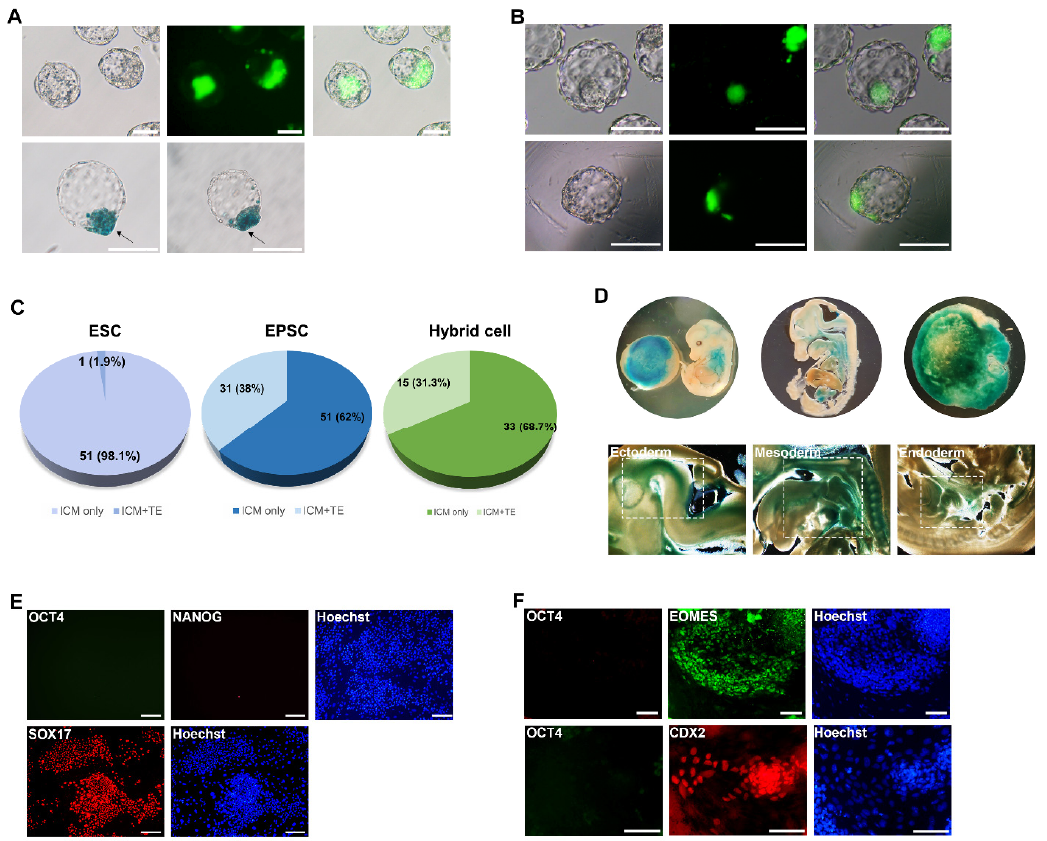
Figure 3. In vivo and in vitro differentiation potential of EPSC-NSC hybrid cells. ( A ) Images of chimeric blastocysts formed by aggregation of morular and EPSC-NSC hybrid cells. Bright-field and green fluorescence images (upper panel) and X-gal staining images (lower panel) of E4.5 chimeric blastocysts. Arrows indicate the X-gal-positive trophectoderm area of chimeric blastocysts. Scale bars: 100 µ m. ( B ) Images of chimeric blastocysts formed by the aggregation of morular and ESCs (upper panel) or EPSCs (lower panel). ESCs and EPSCs expressing GFP ubiquitously were used for chimeric blastocyst formation to trace the cell fate. The contribution to trophectoderm was observed in chimeric blastocysts formed by EPSCs, but rarely formed by ESCs. Scale bars: 100 µ m. ( C ) Contribution rate to ICM only or both ICM and trophectoderm (TE) in chimeric blastocysts formed by aggregation of ESCs, EPSCs, and EPSC-NSC hybrid cells with morula-stage embryos. ( D ) X-gal staining images of E13.5 chimeric embryos formed from chimeric blastocysts (using EPSC-NSC hybrids); entire embryo (upper left), a sectioned embryo (upper middle), and placenta (upper right). X-gal-positive cells (hybrid contribution) are shown in ectodermal, mesodermal, and endodermal tissues of the sectioned E13.5 chimeric embryos formed from chimeric blastocysts (using EPSC-NSC hybrids). Scale bars: 500 µ m. ( E , F ) Immunocytochemistry images of XEN cells and TSC populations directly converted from EPSC-NSC hybrid cells. ( E ) XEN cells from hybrid cells express representative primitive endoderm marker SOX17 (red) without pluripotency marker OCT4 (green). Scale bars: 200 µ m. ( F ) TSCs derived from hybrid cells were shown to express EOMES and CDX2 (red), but not OCT4 (green). Scale bars: 100 µ